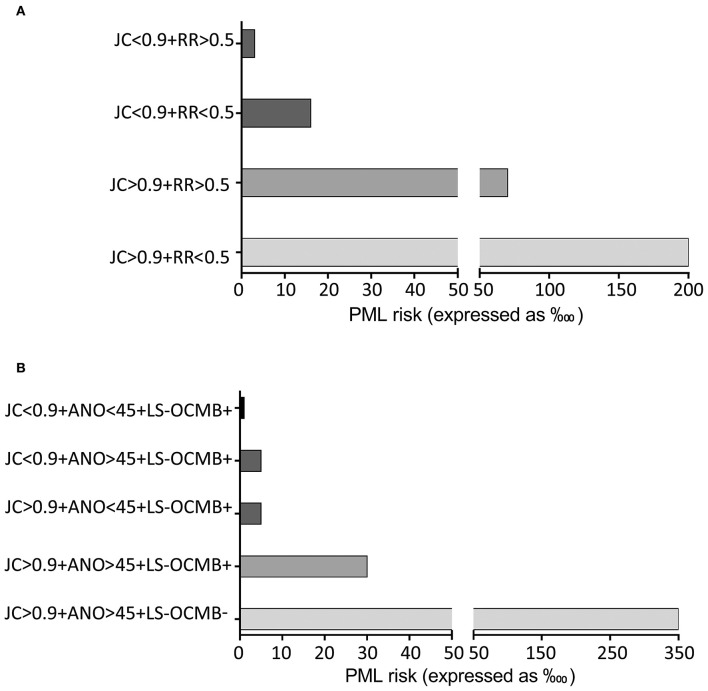
Illustration of predicting progressive multifocal leukoencephalopathy (PML) risk depending on the results of the nomograms. (A) In the whole cohort PML risk associates with the anti-John Cunningham virus antibody levels (JC) and the relapse rate (RR). (B) In patients with lipid-specific oligoclonal IgM band (LS-OCMB) detection, PML risk associated with the LS-OCMB, and JC status, and the age at natalizumab onset (ANO).